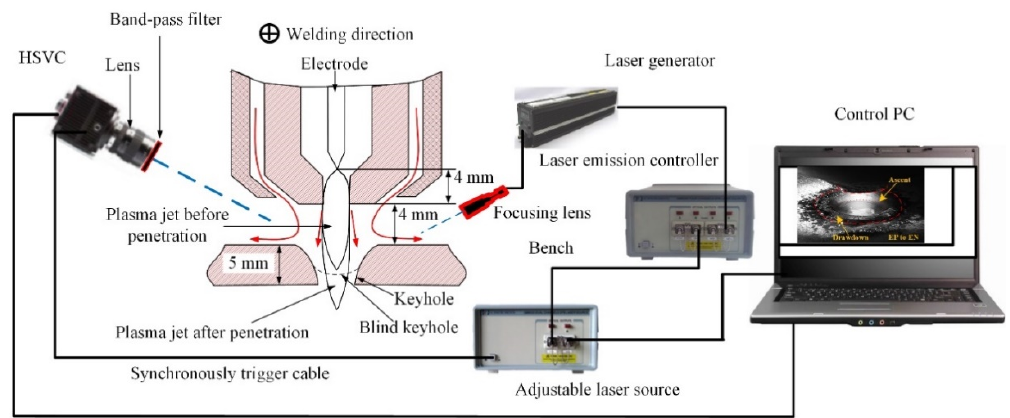
Table 1. Chemical composition of A5052P aluminum alloy (wt. %).